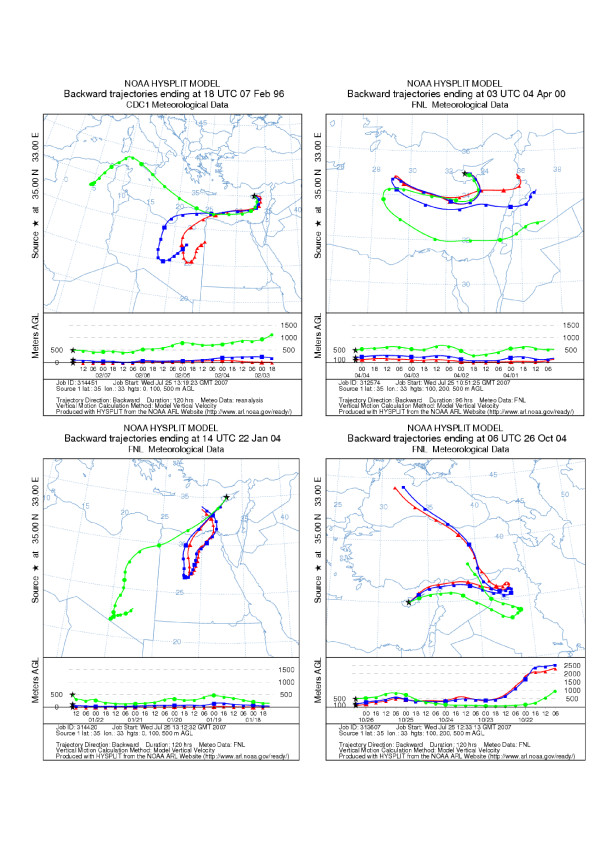
Identification of the likely source of dust storm events. Backwards wind trajectories ending in Nicosia on the day and about the time of the first elevated PM10 concentrations of the four suspected dust storm events.